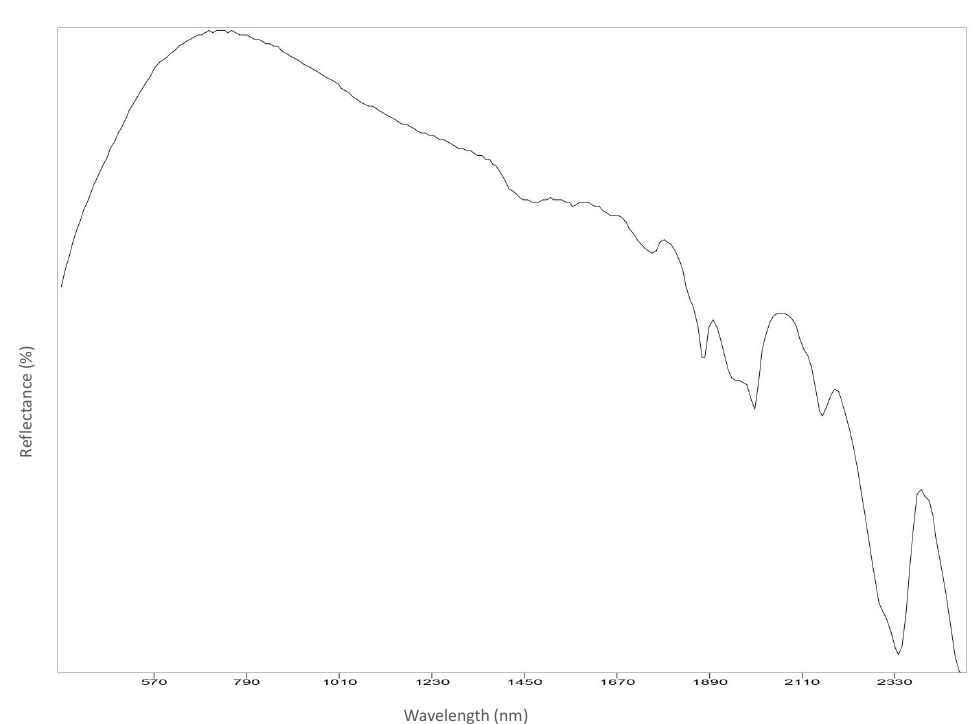
Figure A15. Right chest. Figure A15. Right